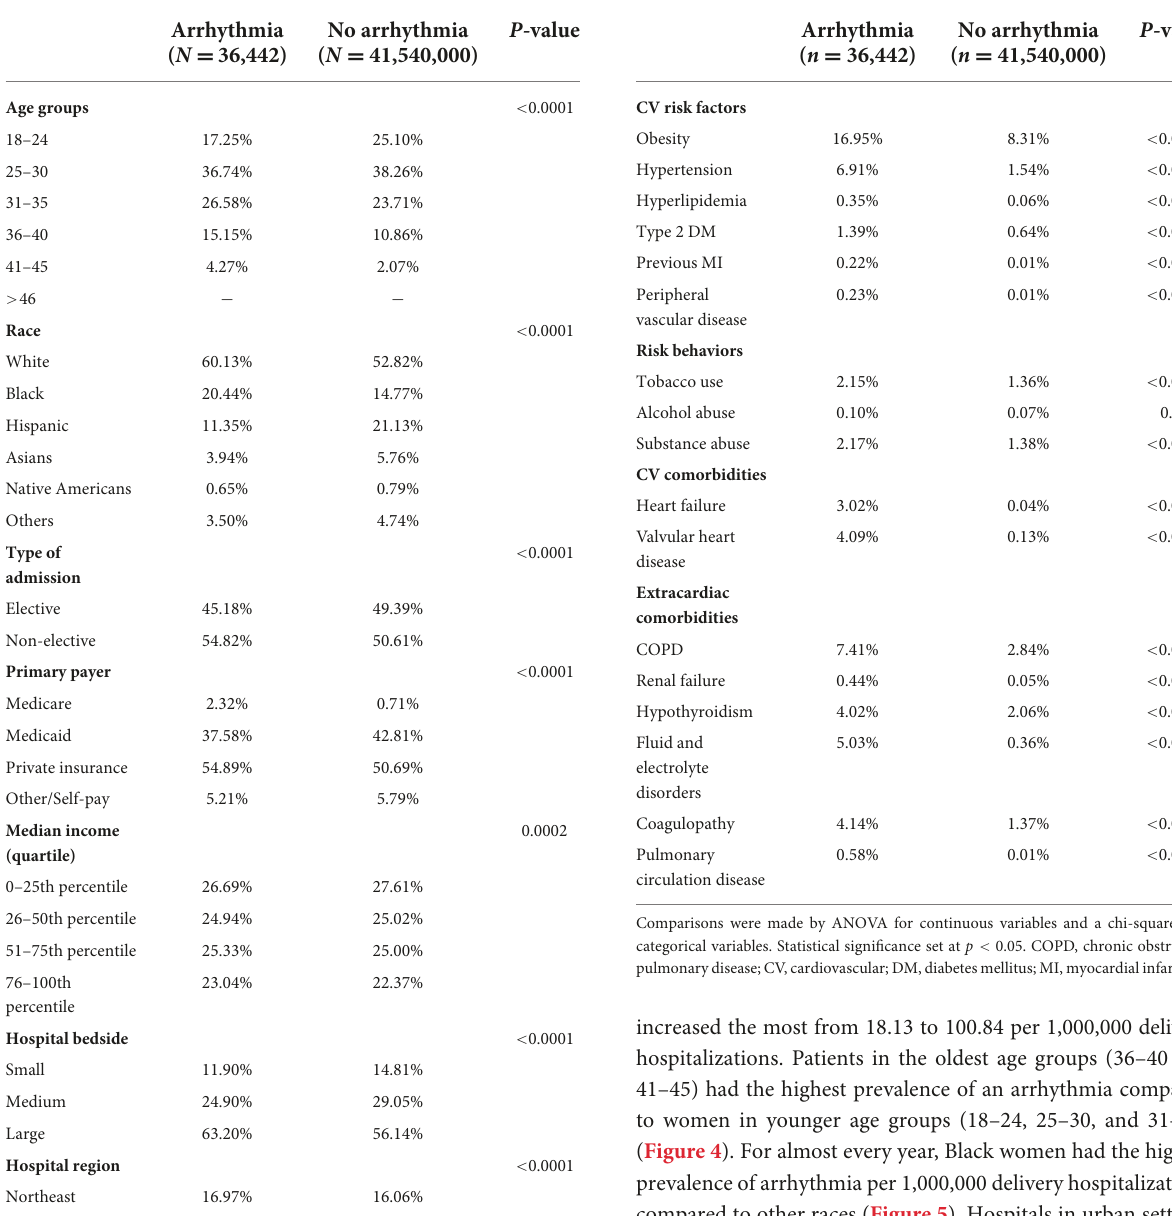
TABLE 2 Comorbidities and complications of women with and without arrhythmia at delivery